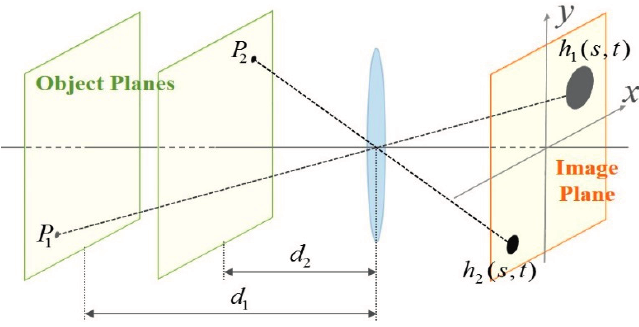
Figure 3. Image formation of two points with different distances from the lens, where